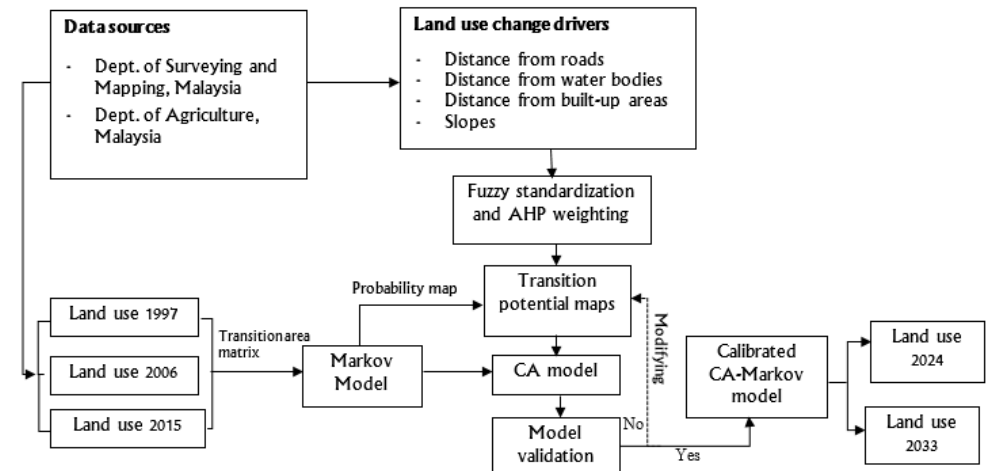
Fig. 2: Land-use maps: 1997, 2006, and 2015 (DOA, 2019)